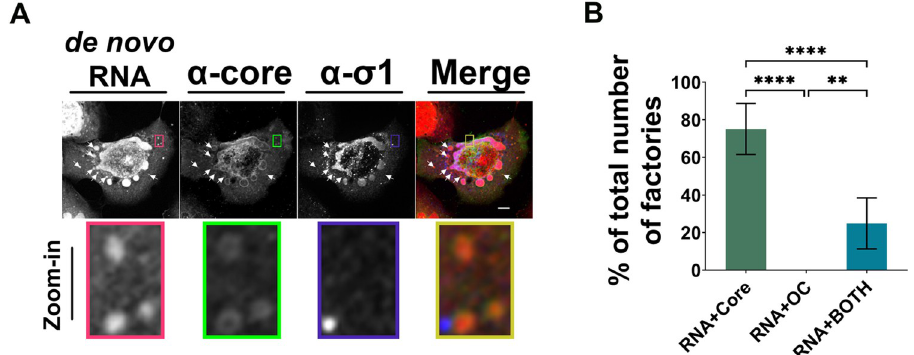
Fig 6. Core-containing factories are transcriptionally active. H1299 cells were infected with reovirus at an MOI of 3 and at 14 hpi, cells were treated with actinomycin D to reduce cell transcription. ( A ) Representative image of cells stained for de novo transcribed RNA using an EZ-click RNA Labelling kit (RNA, red in merged image) between 15 hpi and 18 hpi. Fixed cells were processed for immunofluorescence with rabbit polyclonal α -core antibodies (Alexa Fluor 488, green in merged image) and monoclonal mouse OC protein σ 1 antibody G5 (Alexa Fluor 405, blue in merged images). Images were captured by spinning disk confocal microscopy. Scale bar represents 20 μ m. Highlighted boxes and corresponding close-up images represent example regions positive for core and RNA staining, but negative for σ 1. ( B ) The number of RNA (+) regions containing only core, only σ 1 (OC), or both core and σ 1 (BOTH) were quantified and graphed as a percentage of total RNA (+) objects within the cell at each timepoint. Graph is plotted as mean +/- 95% CI. Statistical analysis is reported as one-way ANOVA with multiple comparisons between the mean of each column. ���� p < 0.0001, ��� p < 0.001, �� p < 0.05, ns > 0.05. Representative of two independent